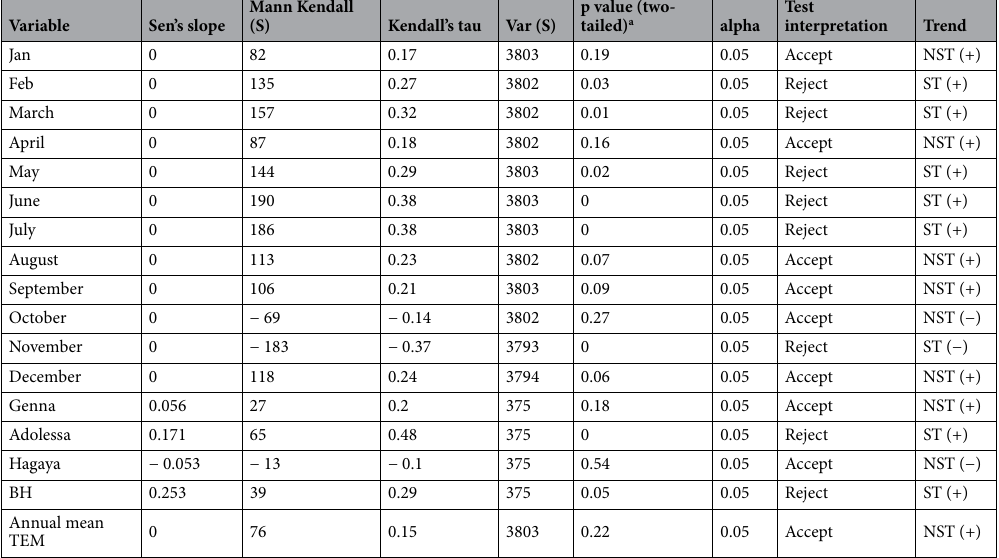
Table 5. Monthly, seasonal and annual maximum temperature MK test results for Moyale station. a An approximation has been used to compute the p value.